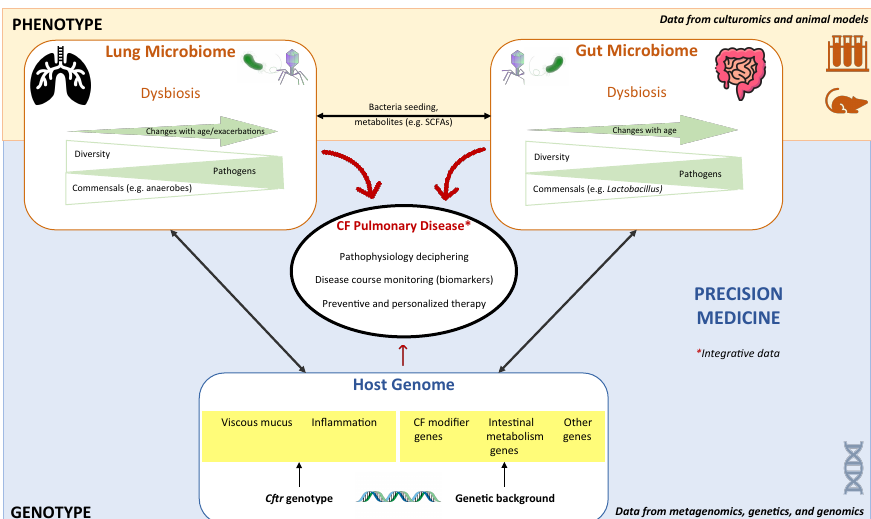
Figure 1. Contribution of microbiome science to cystic fibrosis (CF) research. This figure summarizes the interplay / complementarity between metagenomics and genetics in deciphering CF lung disease, and the combined tools in microbiome research. The genotype profile is stable and fixed since birth, whereas the phenotype provided by the microbiome profiles from both niches, lungs and gut changes with age. Both sets of data are necessary for precision medicine in